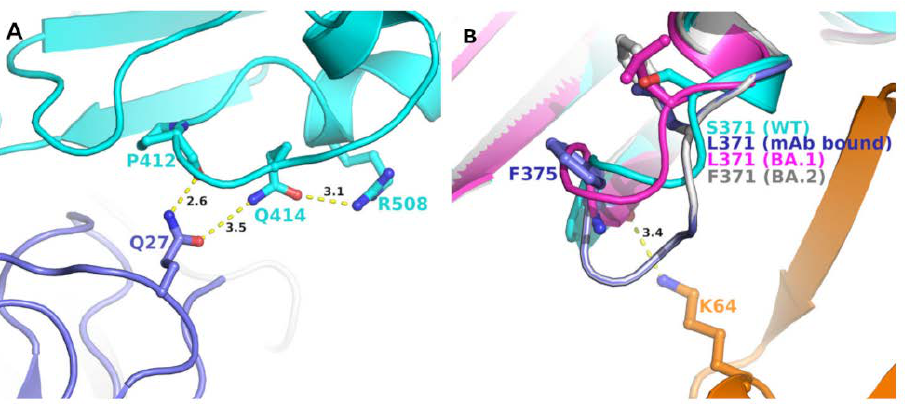
Figure 4. Position of unique BA.2 mutations at the interface of mAb S409 and S403 and S-RBDs. ( A ) Panel A shows the interaction network of R408 with S403 mAb light chain (purple) and S-RBD (BA.1) (cyan). A unique mutation of BA.2 (R408S) is expected to disrupt this interaction pattern and, thereby, the binding affinity of the mAb with S-RBD. ( B ) Panel B shows the change in the conformation of the loop containing S371 (WT, cyan), L371 (BA.1, magenta) (PDB entry 7T9K), BA.1 bound to S304 mAb (purple) (PDB file 7T90), and modeled S371F BA.2 mutation (grey). The interactions between mAb S409 heavy chain orange) and S-RBD (BA.1) is shown in a dotted